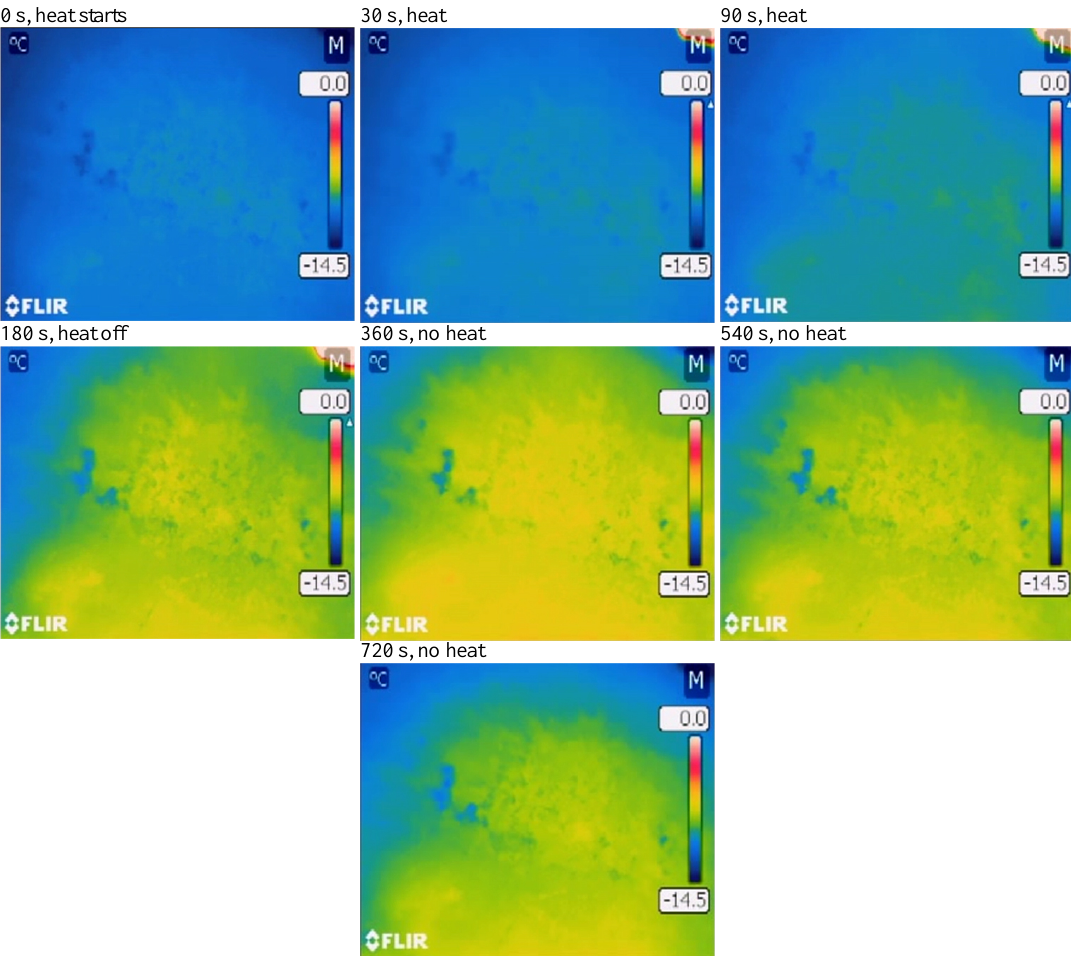
Fig. 6. Seven frames of video from a 2cm thick slice of a layer of rounded grains. The layer has crystals with extent to 0.5 mm and density of 390kg m − 3 . Heat was applied behind the sample from 0 to 180s. Sample width in each image is ∼